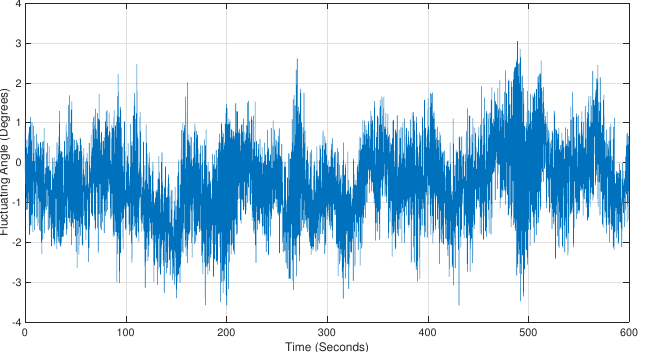
Figure 6. Aeroelastic model results for fluctuating angle between hub thrust and lateral forces for wind speed for a below-rated wind speed of 6 m/s.